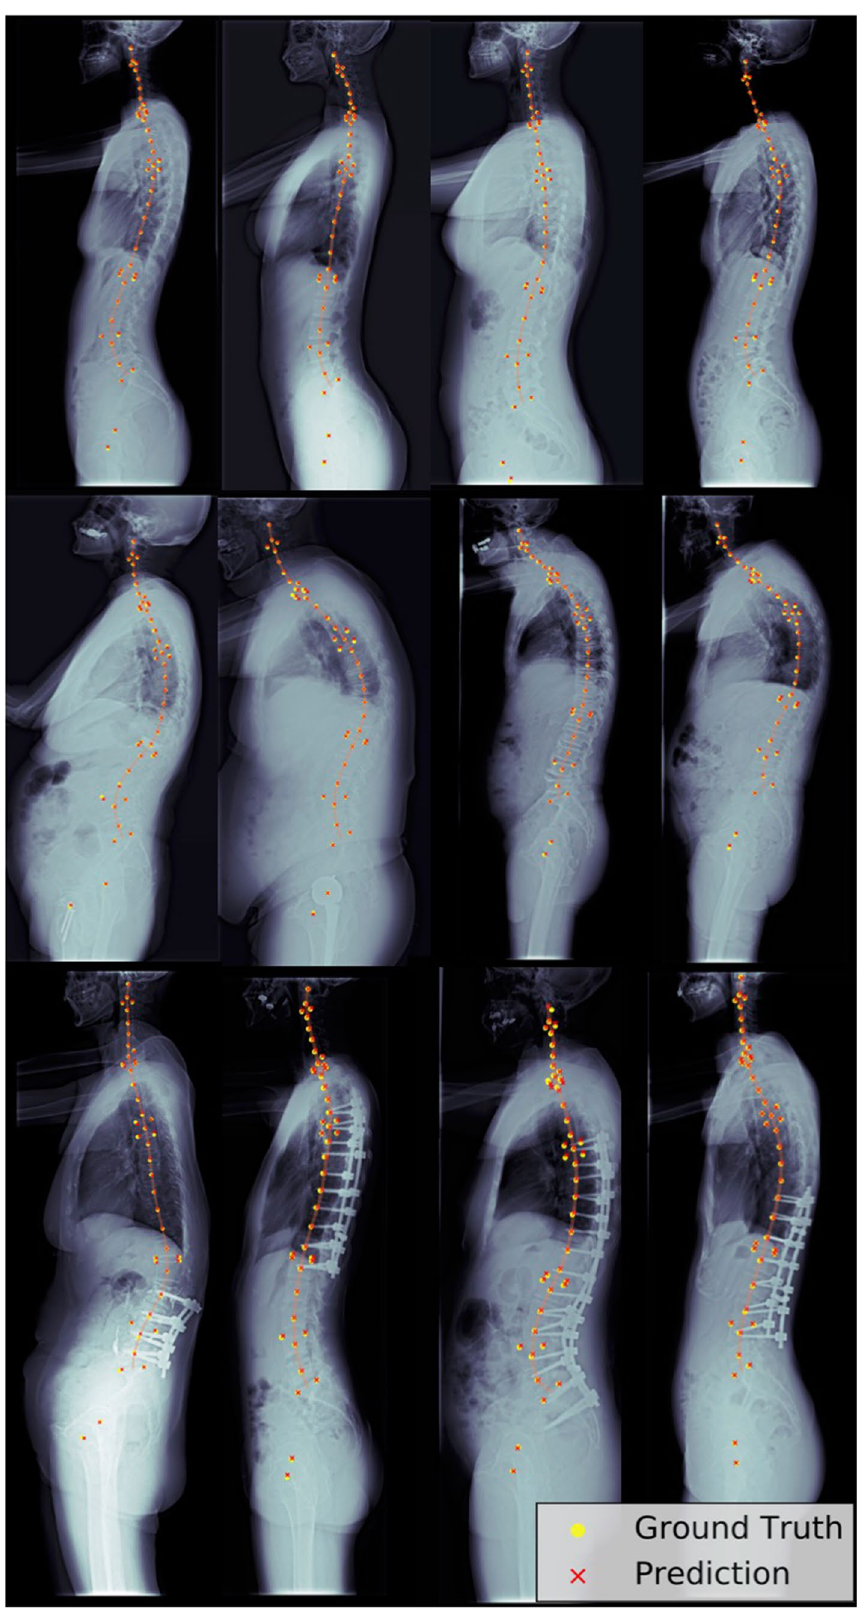
Figure 4. Prediction examples. Examples of model predictions in images with different spinal pathologies, i.e. scoliosis, kyphosis, or implant. For each radiograph, the predicted locations (red crosses) and human-annotated locations (yellow circles) were plotted. We also approximated the spinal curves (orange line) by interpolating the predicted locations of vertebral